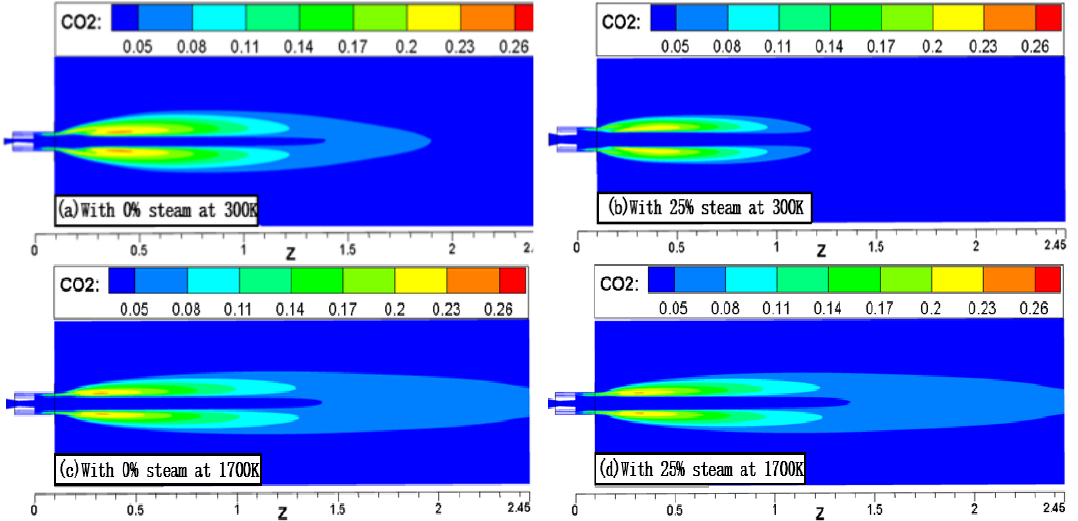
Figure 18. Longitudinal cross-sectional distributions of CO 2 in the coherent supersonic jets under different conditions: ( a ) 0% steam and 100% oxygen at 300 K; ( b ) 25% steam and 75% oxygen at 300 K; ( c ) 0% steam and 100% oxygen at 1700 K; and ( d ) 25% steam and 75% oxygen at 1700 K.